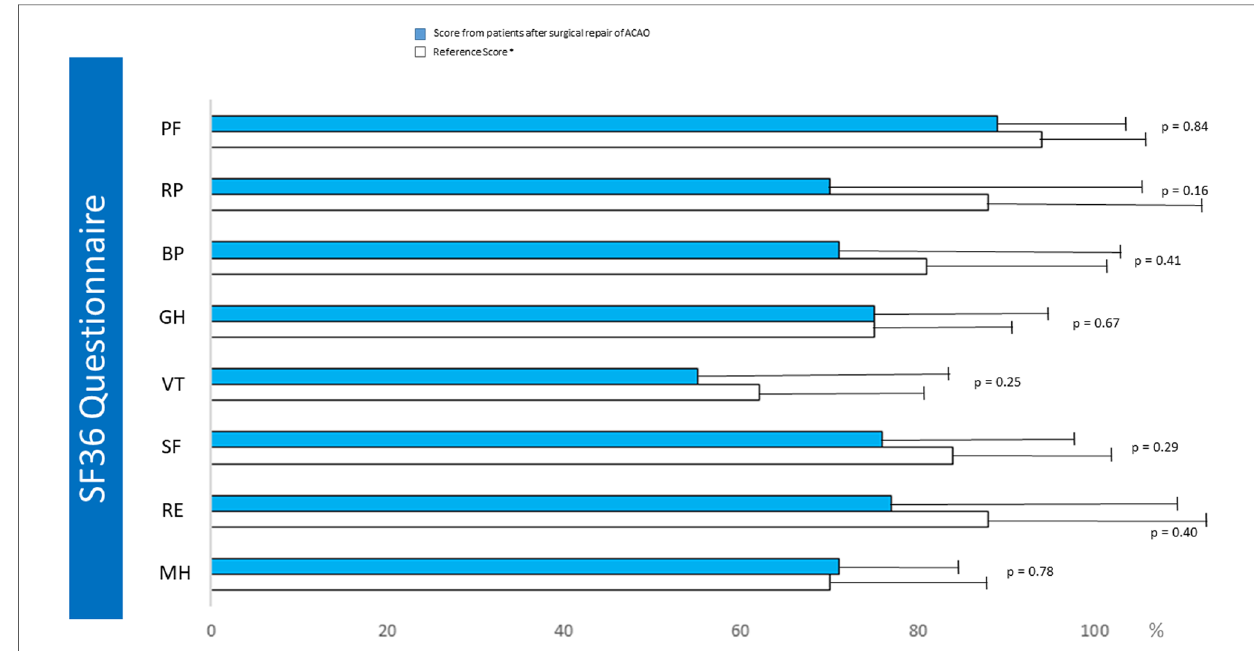
FIGURE 5 Post operative SF36 QOL questionnaire. PF, physical fonction; RP, restriction due physical status; BP, body pain; GH, global Health; VT, vitality; SF, social fonction; RE, restriction due to emotional status; MH, mental health; HT, health trends; PCS, physical score; MCS, mental score. *Reference score from